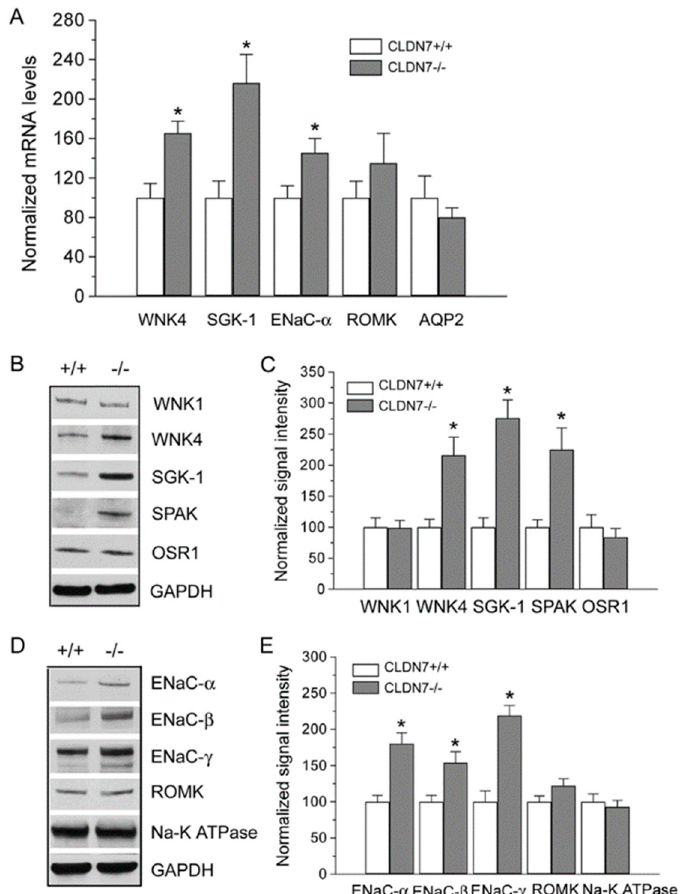
Figure 3. Deletion of CLDN7 had a significant effect on gene and protein expression levels of WNK4, SGK-1, and ENaC. ( A ) Real-time RT-PCR analysis of WNK4, SGK-1, ENaC- α , ROMK, and AQP2 mRNA levels in CLDN7 +/+ and CLDN7 − / − CD cells. Each measurement was normalized to its β -actin level. * p < 0.05. n = 3. ( B ) Western blotting analysis of several protein kinase levels in CD cells. CLDN7 +/+ and CLDN7 − / − CD cells were lysed in RIPA (radio-immunoprecipitation assay) buffer and a total of 30 µg protein for each lane was loaded onto the SDS NuPAGE gel. Membranes were blotted against WNK1, WNK4, SGK-1, SPARK, and OSR1. GAPDH (glyceraldehyde 3-phosphate dehydrogenase) staining was used as a loading control. ( C ) Densitometry analysis of protein expression levels shown on ( B ). Each band intensity for CLDN7 +/+ CD cells was normalized and set as a reference. * p < 0.05. n = 3. ( D ) Western blotting analysis of several ion channel levels in CD cells. Equal amounts of CLDN7 +/+ and CLDN7 − / − CD cell lysates were loaded onto the SDS NuPAGE gel and the membranes were probed against ENaC- α , - β , - γ , ROMK, and Na + -K + -ATPase. ( E ) Densitometry analysis of protein expression levels shown on ( D ). Each band intensity for CLDN7 +/+ CD cells was normalized and set as a reference. * p < 0.05. n = 3.